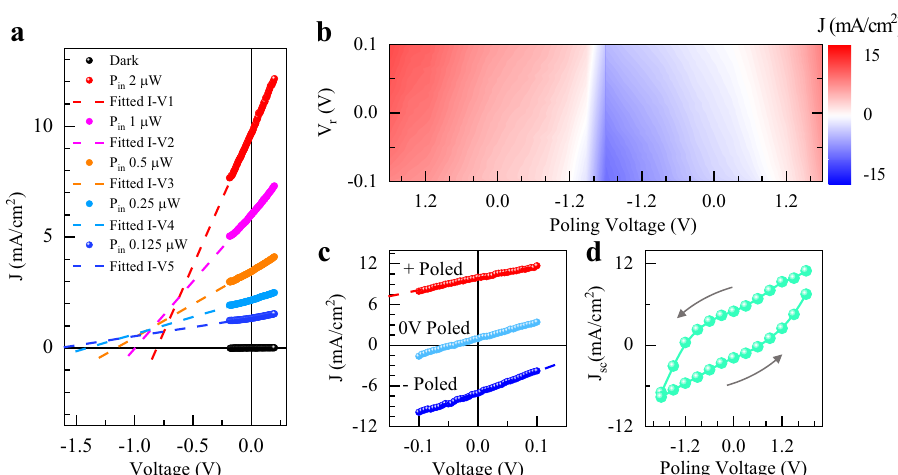
Fig. 2 Switchable photovoltaic effect in 2D BPVE device. a The characteristic output I – V curves of device #2 at dark (black dots) and bright (color dots) conditions. The excitation light source is the laser line with 405 nm wavelength. The dotted color lines represent the linear fi t on the output I – V curves measured at bright conditions with different laser power. b The photovoltaic behavior under different poling voltages. The poling voltage is swept from + 1.8 to − 1.8 V and then backward to + 1.8 V. The reading bias is set to be within ±0.1 V. The color represents the magnitude of the generated photocurrent density. c Extracted output I – V curves at speci fi c poling voltages from b with the red, blue, and dark blue dots representing the positively, zero voltage, and negatively poled states respectively. d The plot of I sc as a function of the poling voltage. The arrows indicate the measurement sequence. Table 1 The results of short-circuit current density J sc , open-circuit voltage V oc , photoconductivity σ , fi ll factor (FF), and power conversion ef fi ciency η for samples with thickness d and excitation intensity P in .